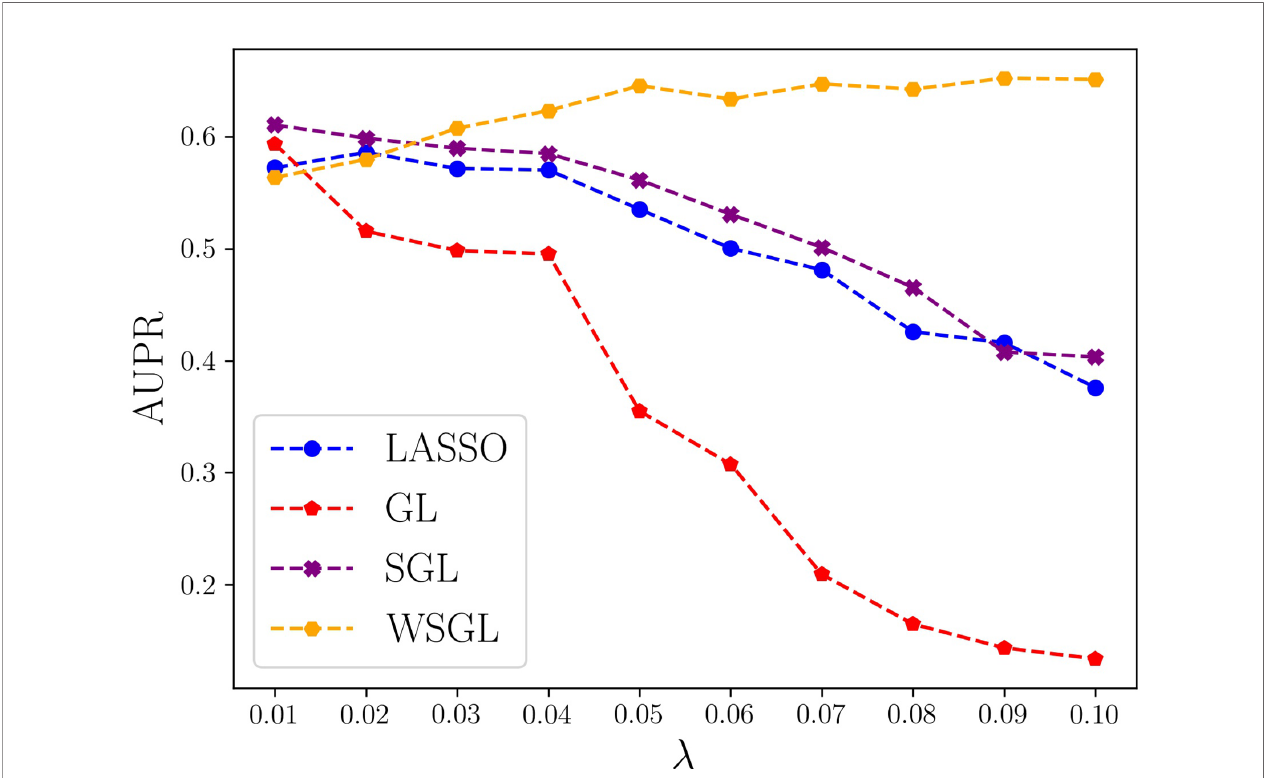
FIGURE 2 | Precision-recall (PR) curves of WSGL and the other methods for varying l .